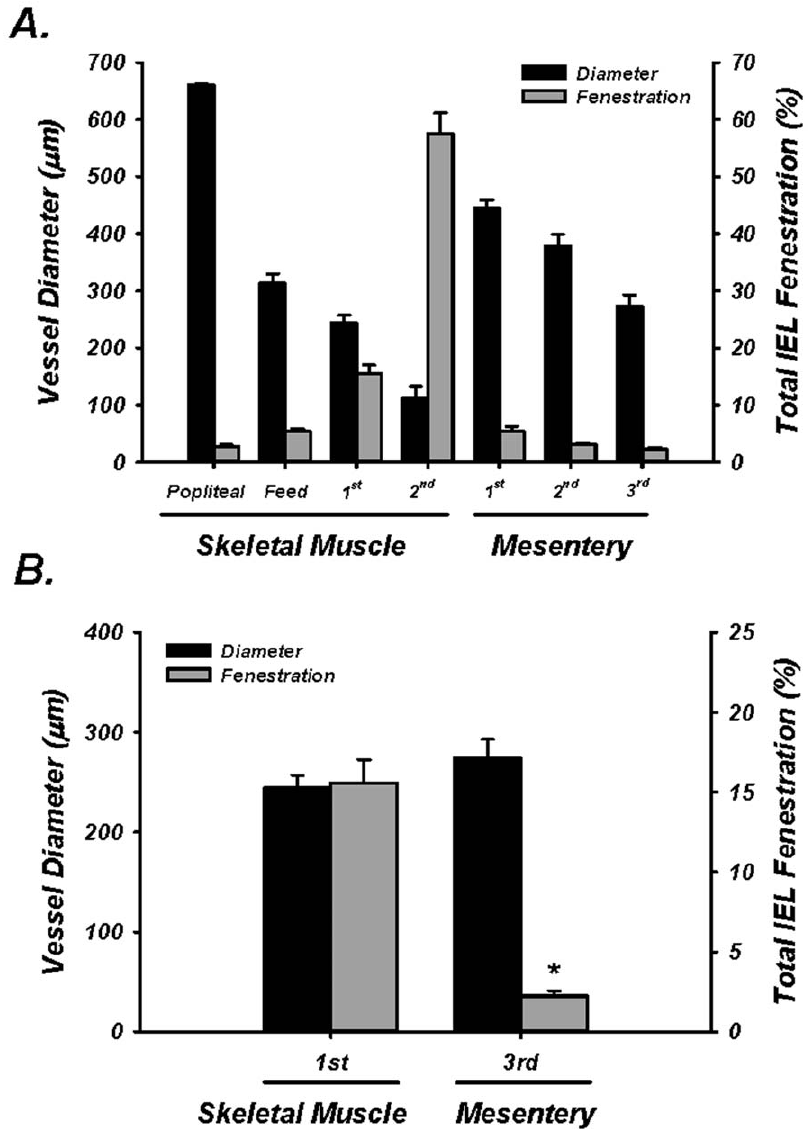
Figure 4. Vessel diameter vs. total IEL fenestration. A: Diameter (black bars) and total IEL Fenestration (gray bars) for skeletal muscle and mesenteric arteries for all vessels. B: Diameter (black bars) and total IEL Fenestration (gray bars) for size-matched 1 st order skeletal muscle arterioles and 3 rd order mesenteric arteries. *= P , 0.05 vs skeletal muscle.